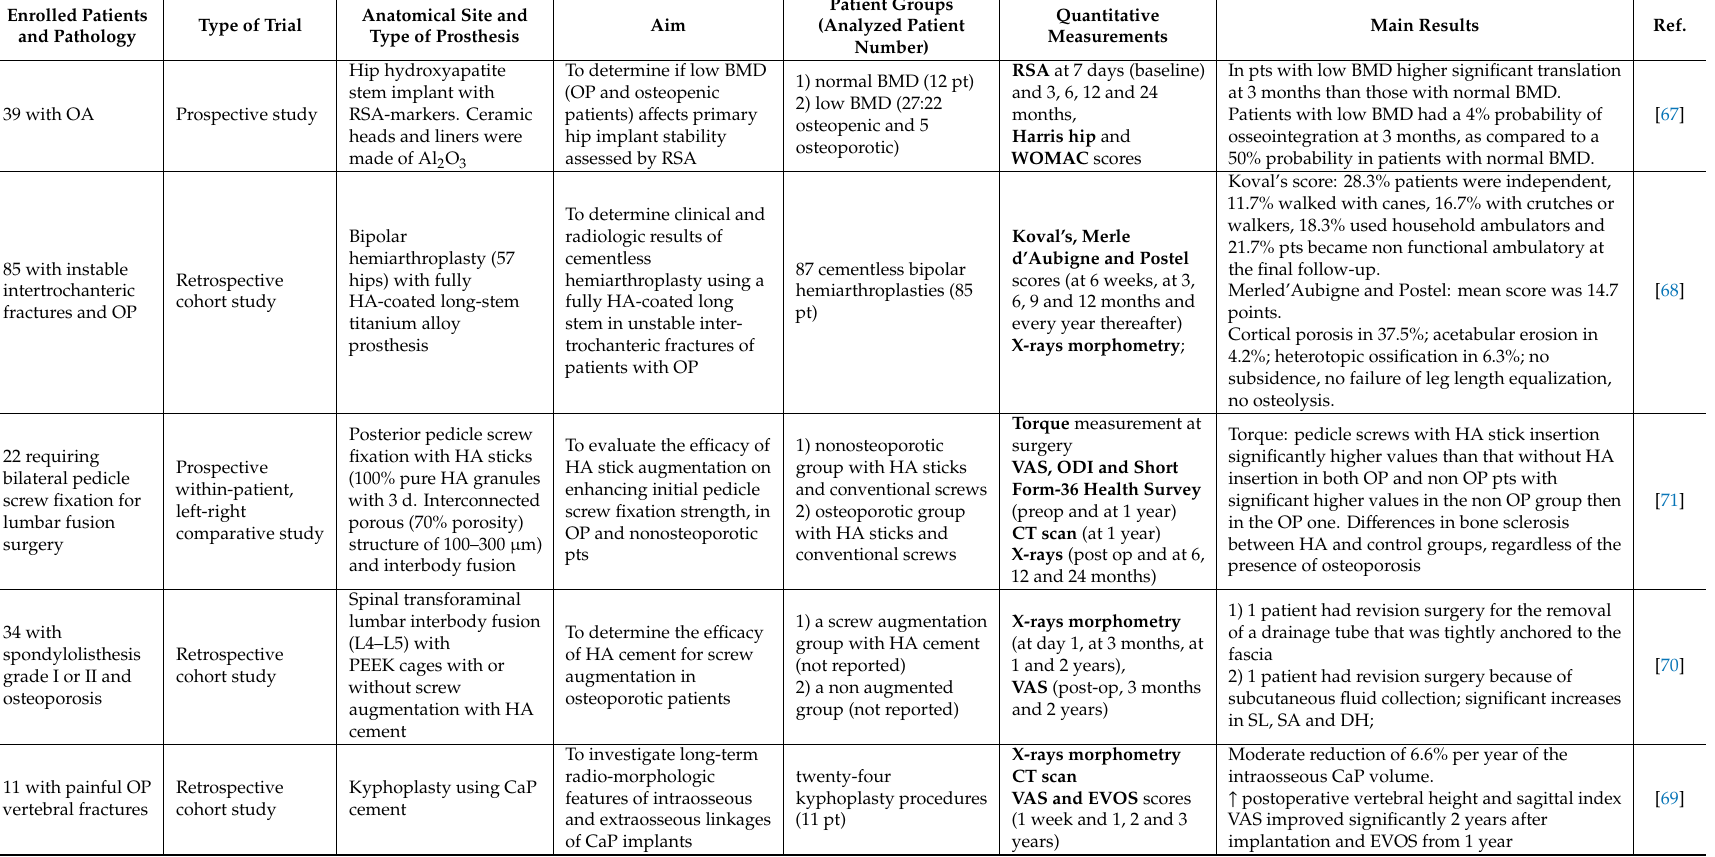
Table A3. Data extraction from clinical